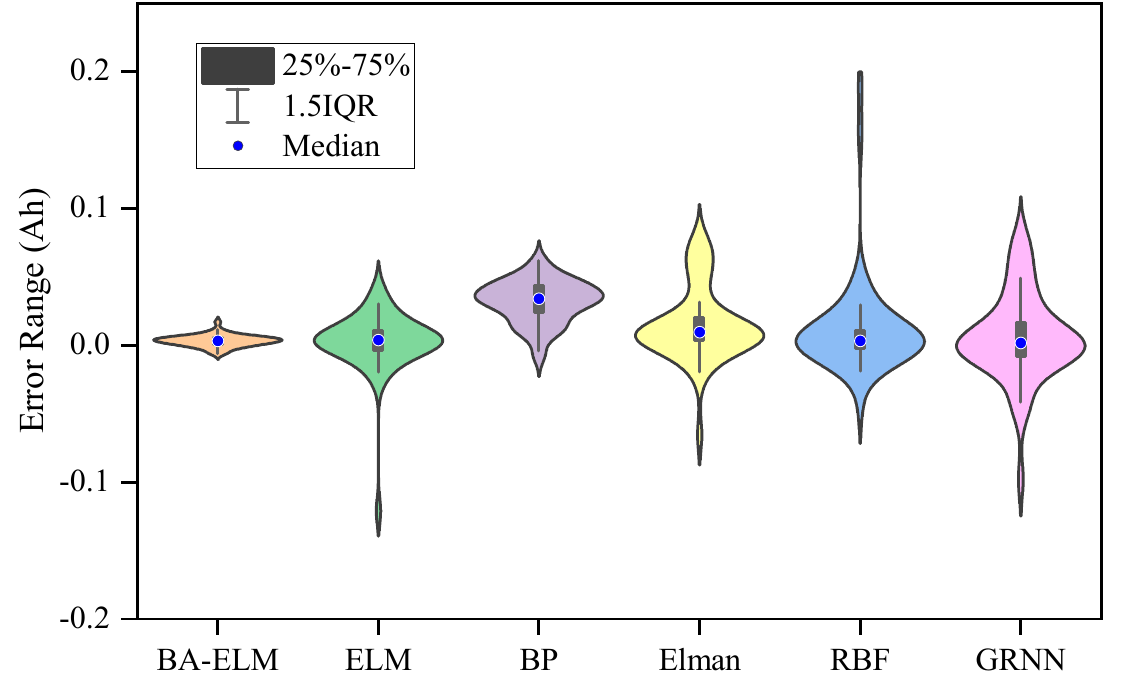
Figure 22. Violin diagram of six models.